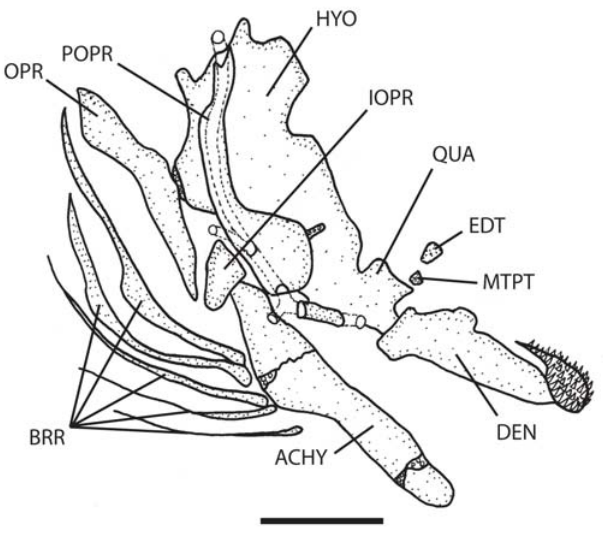
Fig. 1. Lateral view (anterior to the right) of the suspenso- rium, hyoid arch and lower jaw of Pseudobunocephalus lundbergi , ANSP 172505, paratype. Scale bar equals 1